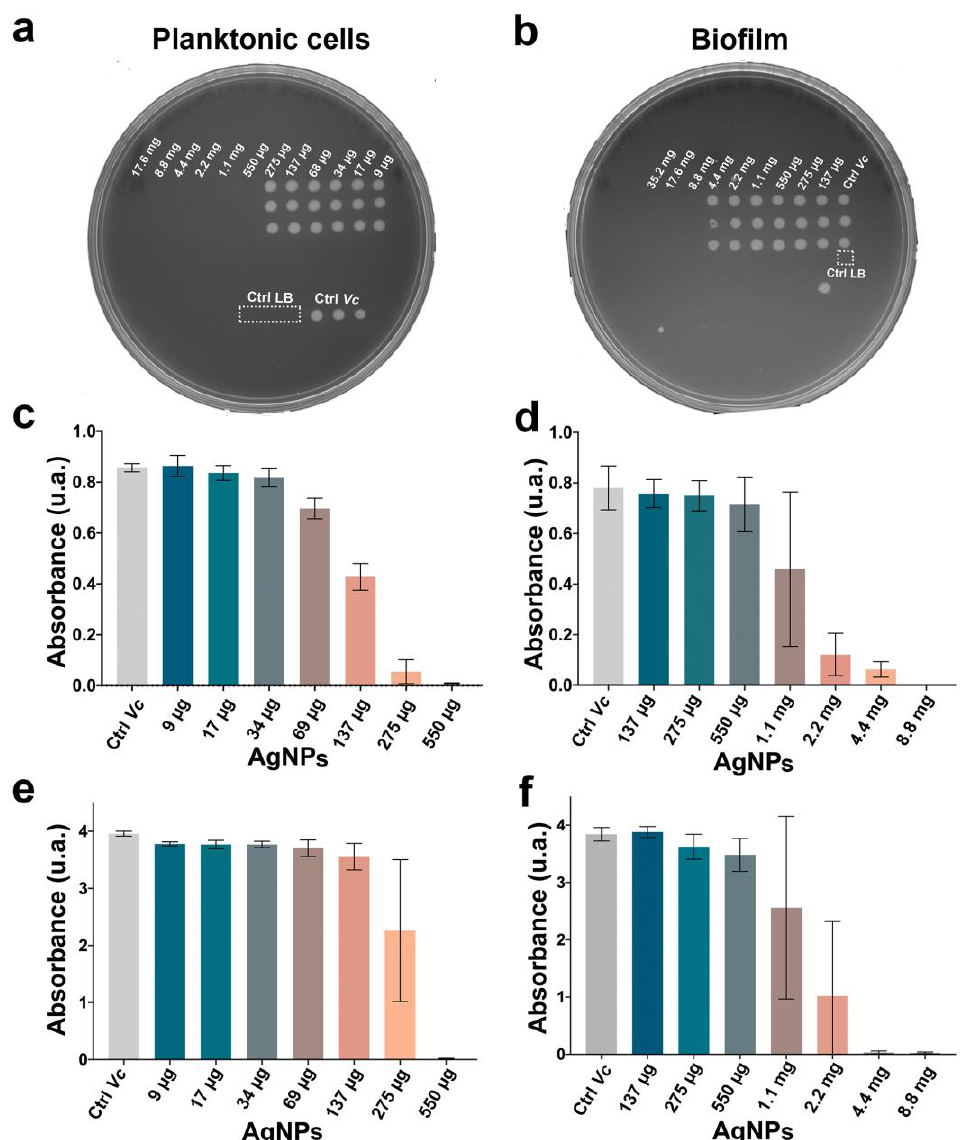
Figure 2. AgNPs ’ minimal bactericidal concentrations of planktonic cells (PL) and biofilms (BF). By stamping ( a , b ), MTT assay ( c , d ), Turbidity ( e , f ). Three biological replicates (each one with three technical replicates). V. cholerae without treatment ( Ctrl Vc ); Lysogeny Broth (LB) media as a control with no bacterial contamination; MTT (3- (4,5-dimethylthiazol-2-yl) -2,5-diphenyltetrazolium bromide).